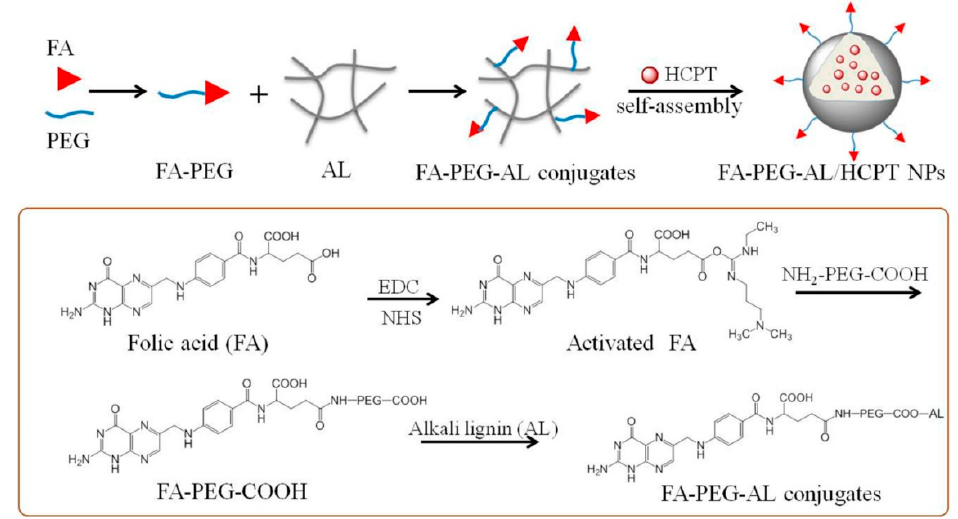
Figure 11. Synthesis of FA-PEG-AL/HCPT NP [94].